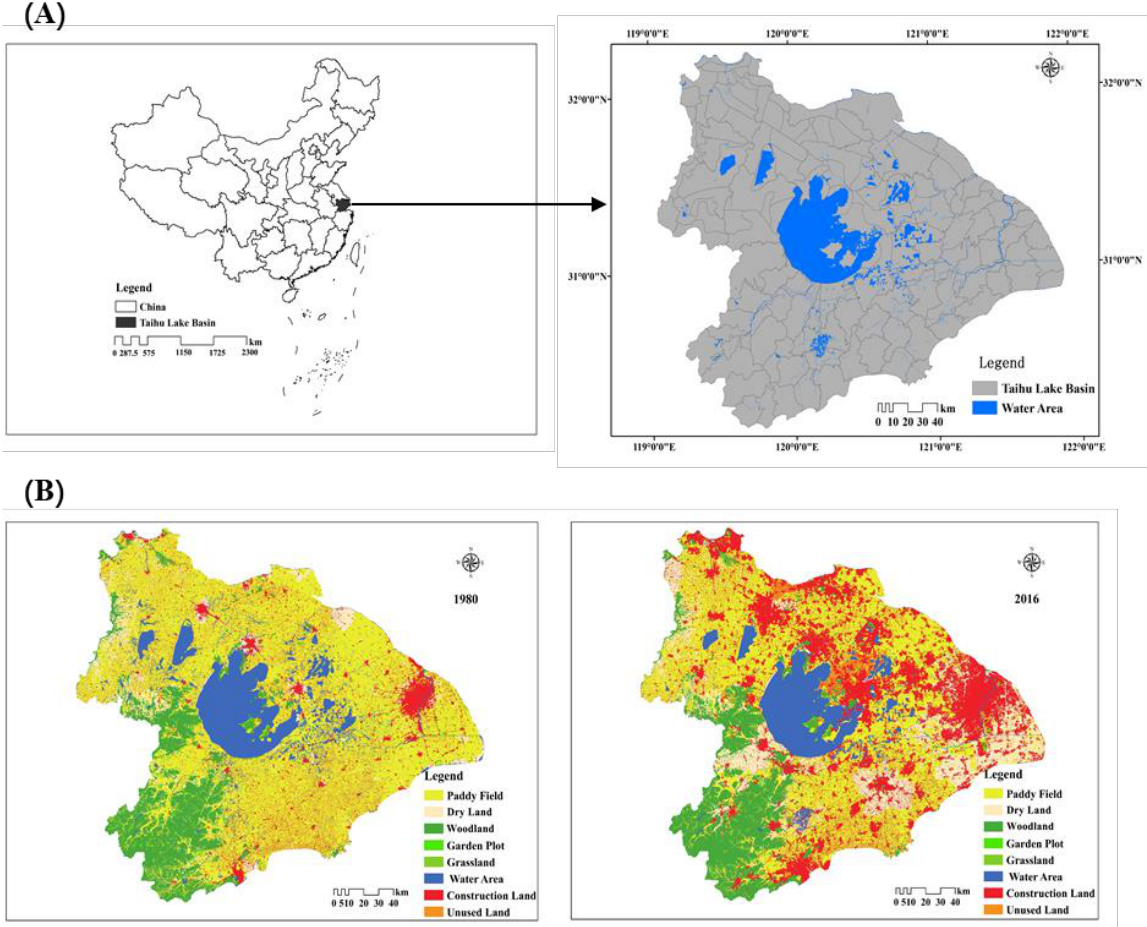
Figure 1. The site of the Taihu Lake basin ( A ) and land use type changes from 1980s to 2000s in Taihu Lake basin ( B ).